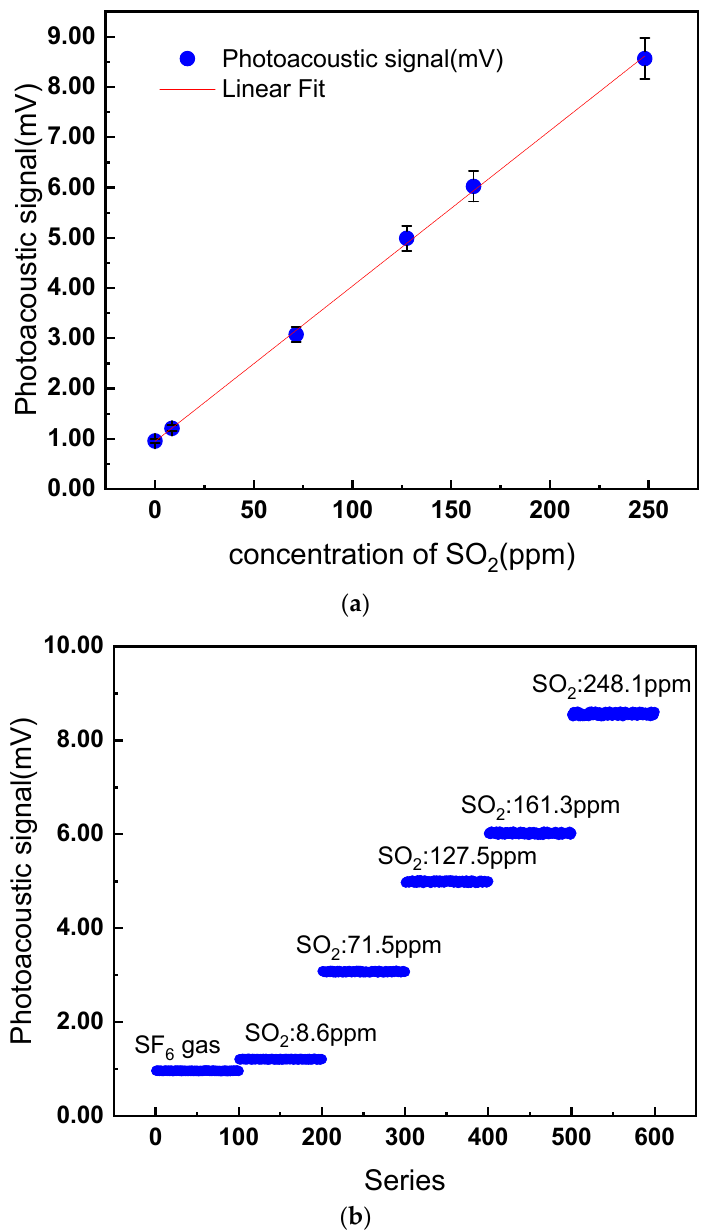
Figure 8. Detection properties of the SO 2 detection system: ( a ) the linearity of the PA signal response and ( b ) series of measured results of different SO 2 concentrations.